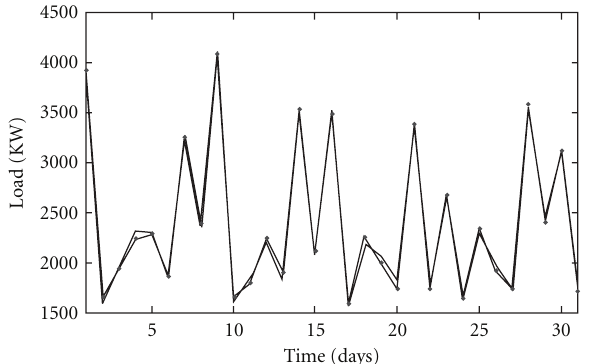
Figure 7: Comparison of actual load (–) and forecasted